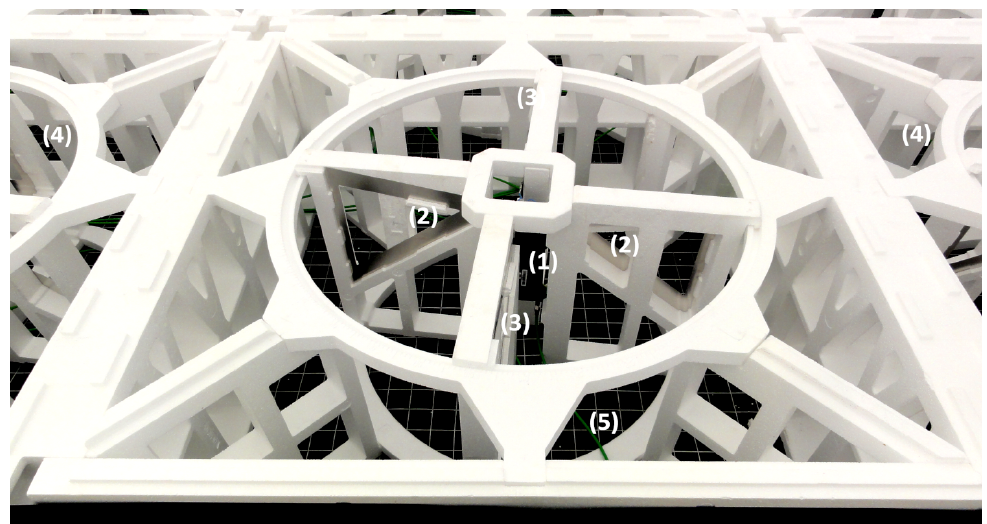
Figure 3. HBA tile internal structure. 1—preamplifier, 2—dipoles for one polarization, 3—dipoles for second polarization, 4—adjacent dipoles, 5—connection to amplifier and